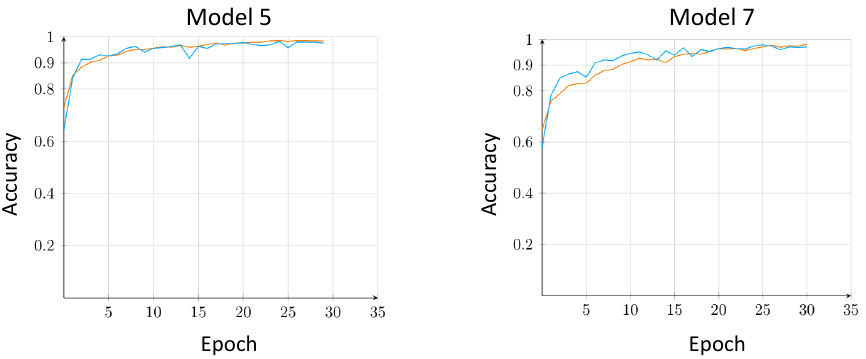
Figure 2. Comparison of the accuracy track between Model 5 and Model 7 in Experiment 1. Orange and blue lines represent the training and validation phase,